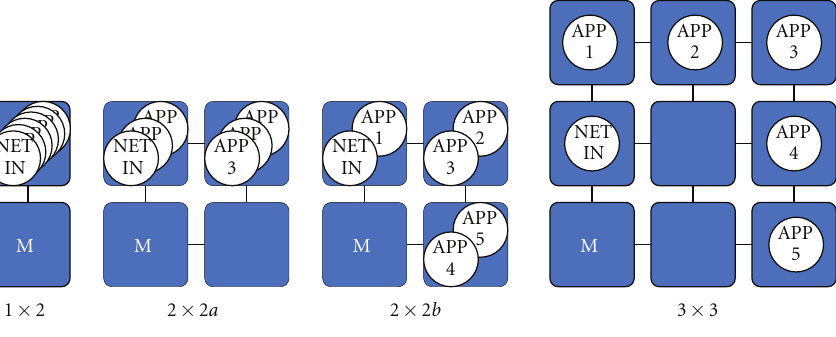
Figure 13: MPSoC configurations.